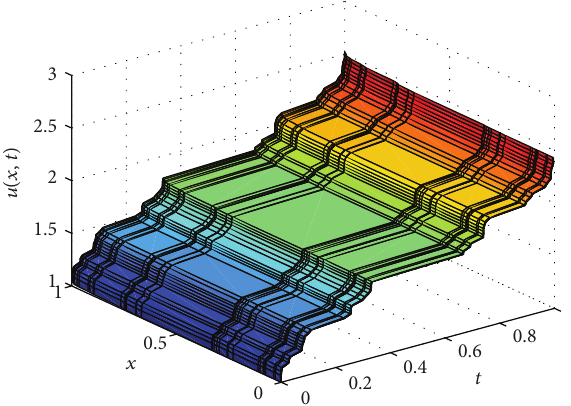
Figure 3: Plot of 𝑢(𝑥,𝑡) with the parameters 𝛼 = ln 2/ ln 3 and 𝑘 = 50